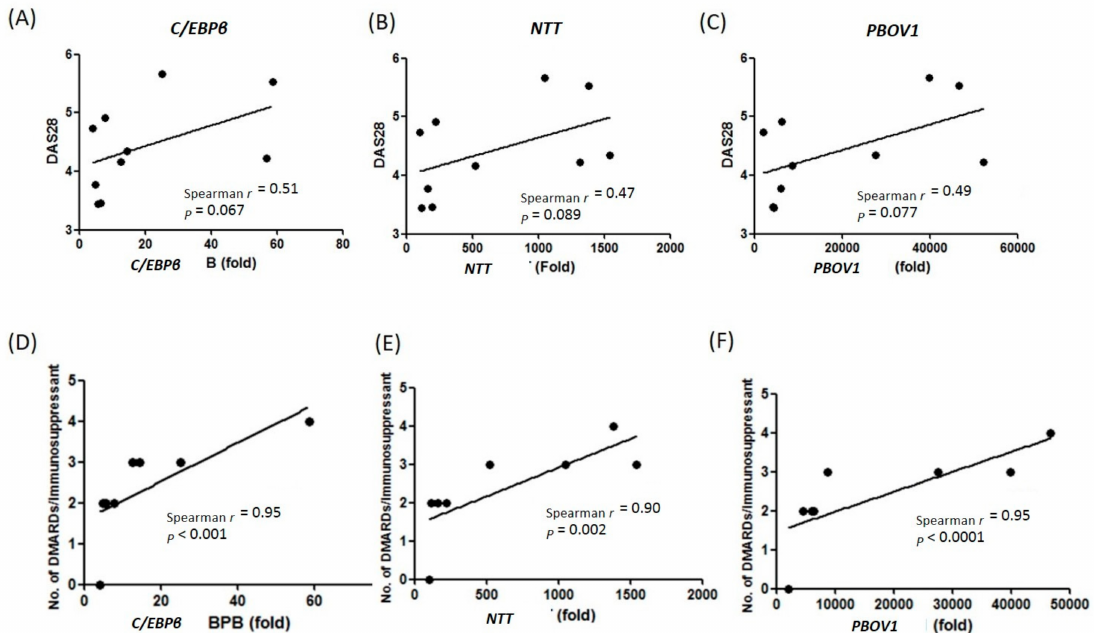
Figure 4. Correlations of C/EBP β /NTT/PBOV1 expression levels with RA disease severity score DAS28 ( A – C ) and usage of multiple disease-modifying antirheumatic drugs (DMARDs)/immunosuppressant ( D – F ). RNA expression levels are shown as folds compared with median levels of healthy